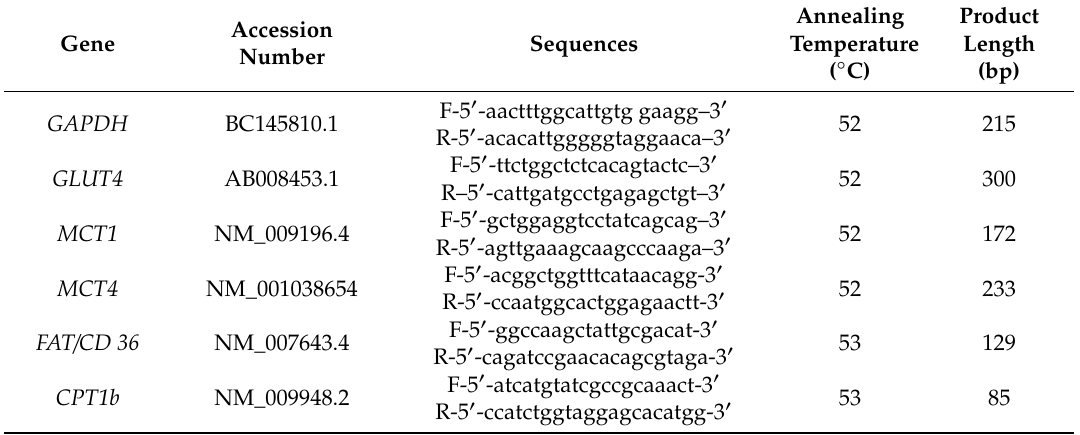
Table 1. Primer sequences, annealing temperatures, and product lengths.